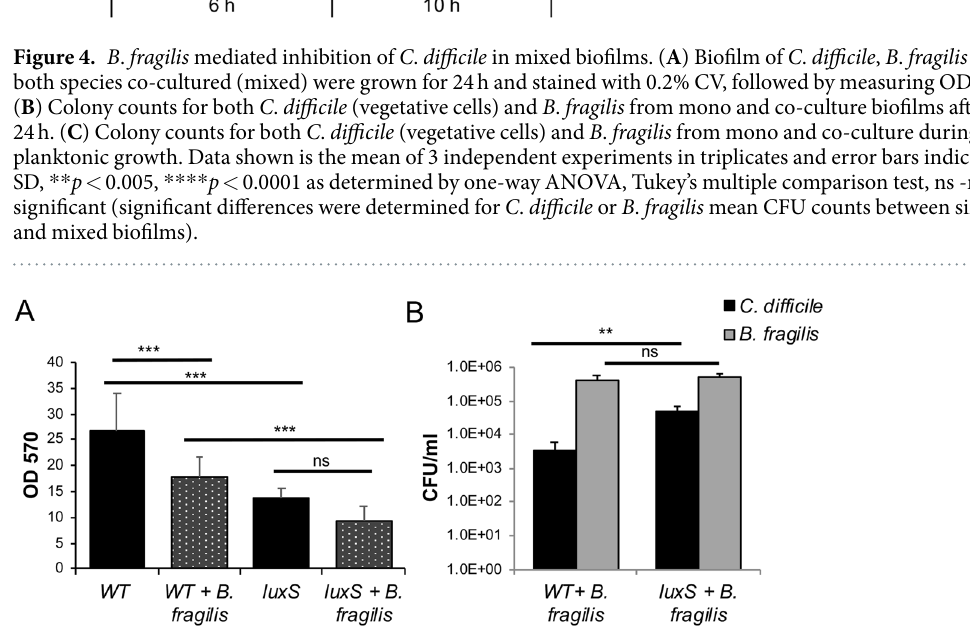
Dual species RNA-seq analysis shows altered metabolism in C . difficile and B . fragilis in the absence of Luxs. To investigate mechanisms underlying the C . difficile inhibition mediated by B . fragilis , we performed an RNA-seq analysis to compare biofilm monocultures of C . difficile WT, luxS or B . fragilis with mixed